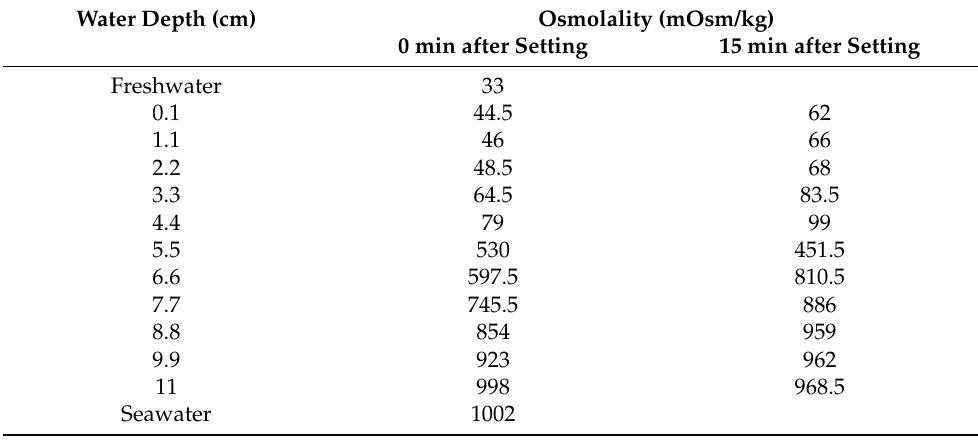
Table 2. Changes in water osmolality for a salinity preference experiment. Water Depth